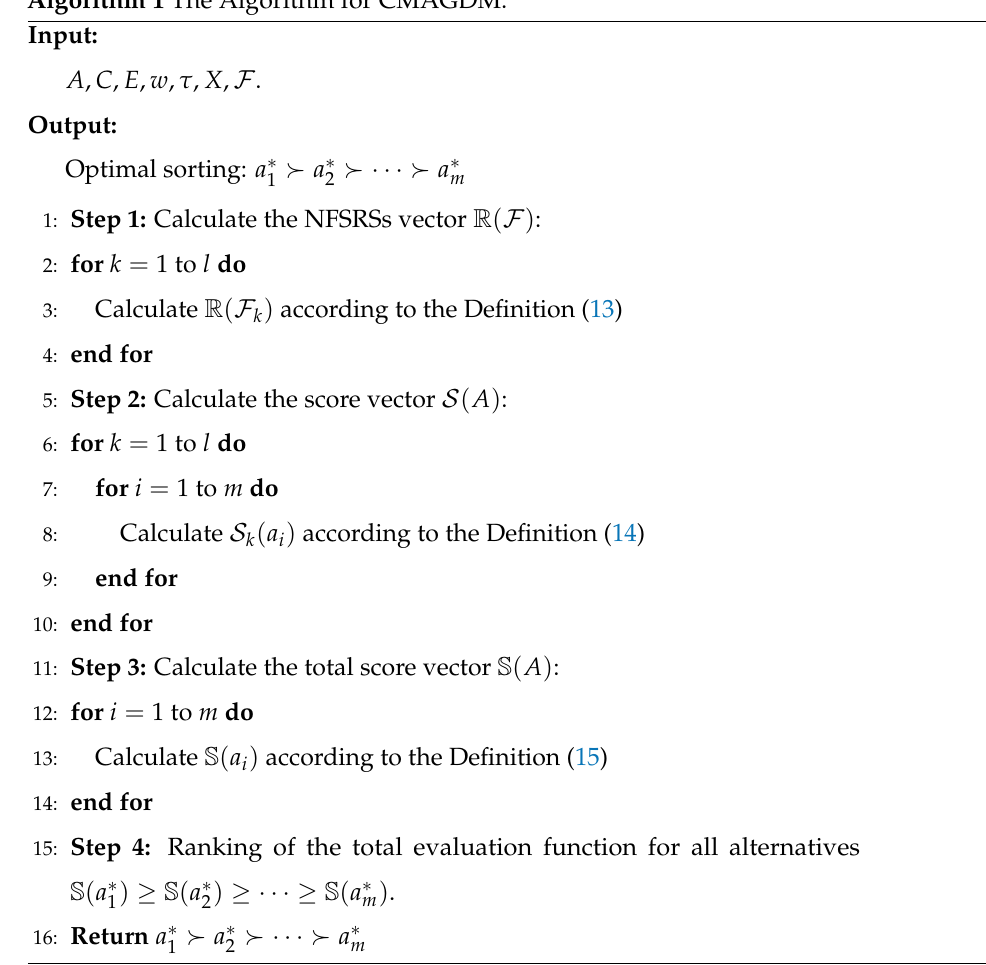
Algorithm 1 The Algorithm for